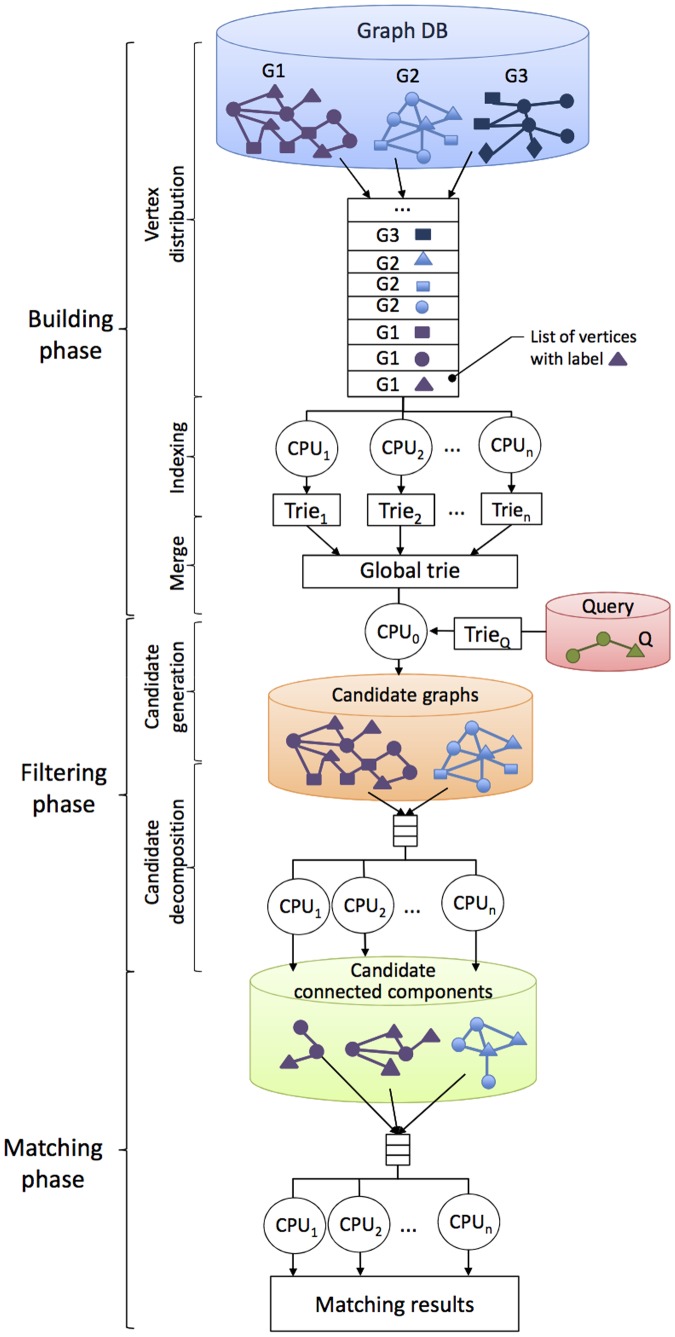
Schema of GRAPES.